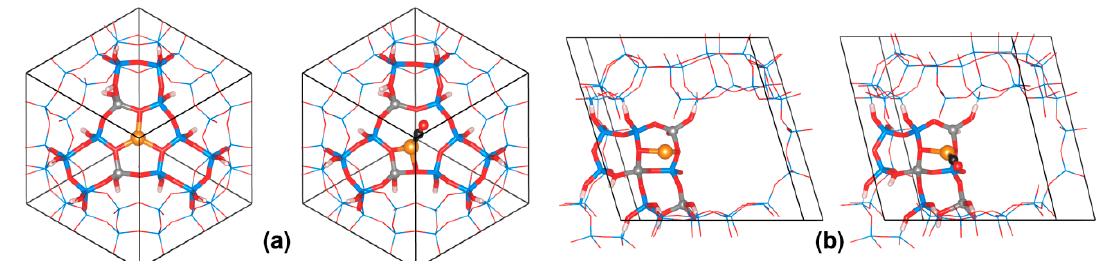
Figure 3. The optimized structures of the QMPot models used for the modeling of CO adsorption on Cu(I) exchanged FAU, the embedded cluster (QM level) depicted with balls and sticks, the remaining unit cell contents (MM level) with lines: ( a ) the models of site II (12T cluster), the equilibrium 3(3) Cu(I)–lattice coordination is switched to 2(1) upon CO adsorption; ( b ) site III model (8T cluster), here, the Cu(I) binding mode is 2(2) before and after CO adsorption. m ( n ) coordination denotes the Cu(I) ion bound to the m lattice O atoms belonging to n distinct tetrahedra. The following colors were used for the atoms: Cu—orange, Al—grey, Si—blue, O—red, H—white, C—black.